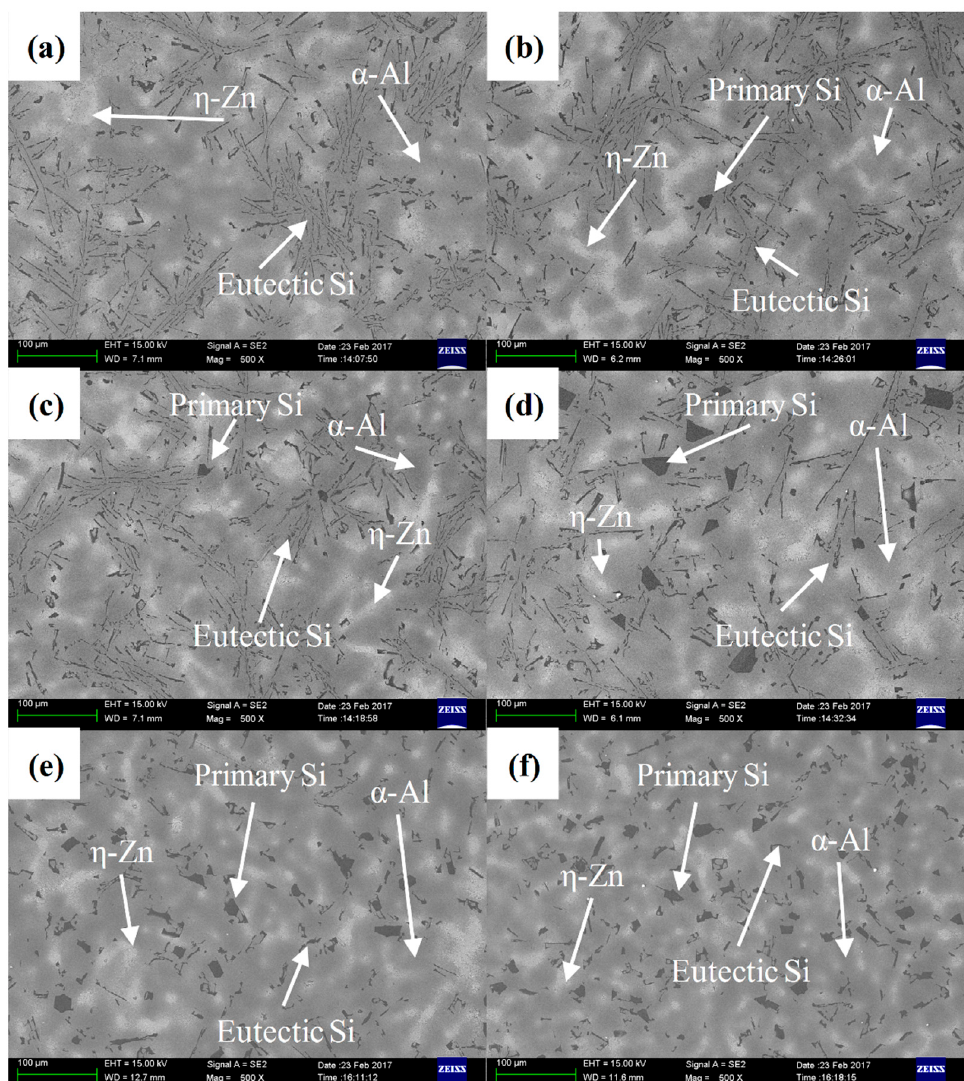
Figure 9. Microstructure of high-purity Al-40Zn-5Si alloy with different P contents: ( a ) 0, ( b ) 5 ppm,